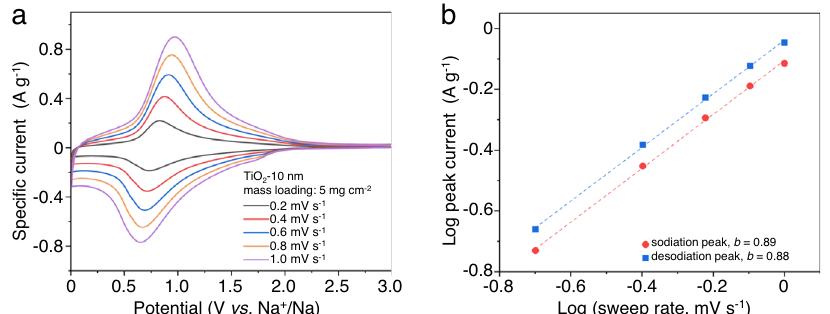
Fig. 6 | High-massloading performanceofTiO 2 NPs. The smallvoltageoffset in CVcurves ( a )and the b -valueanalysis ( b )of the TiO 2 -10nmfor5mgcm − 2 mass loading. The results indicate that surface-controlled kinetics also occur in thick